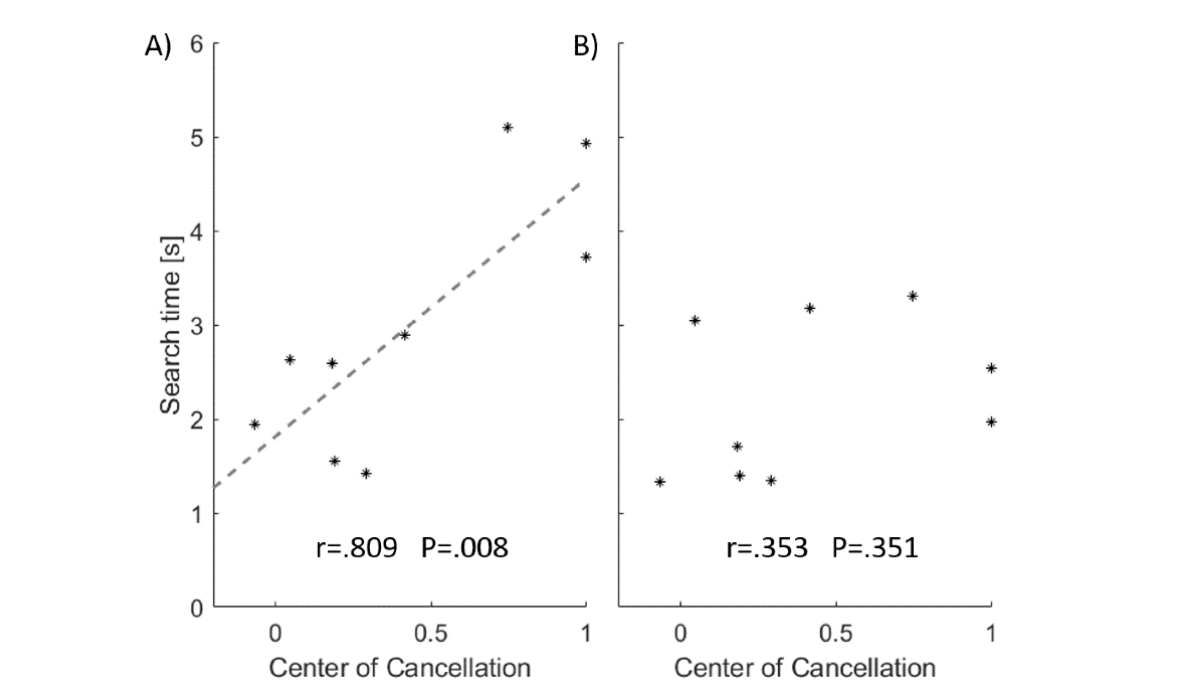
Figure 6. Correlation between the Center of Cancellation (CoC; as an objective measure of neglect severity) in the Sensitive Neglect Test (SNT) and the mean search time for the (A) left hemispace and (B) right hemispace in patients with